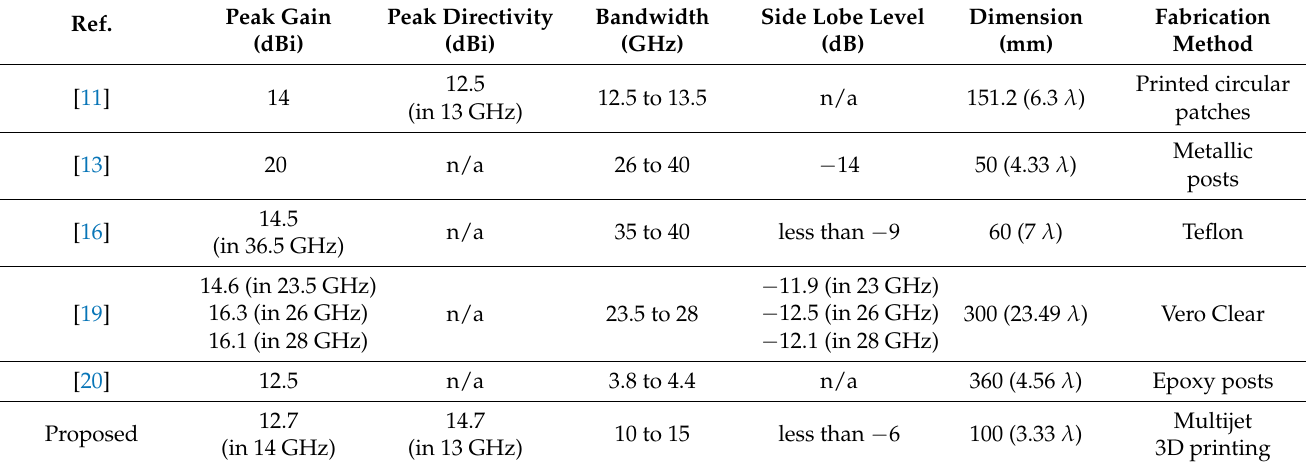
Table 1. Comparison of proposed antenna